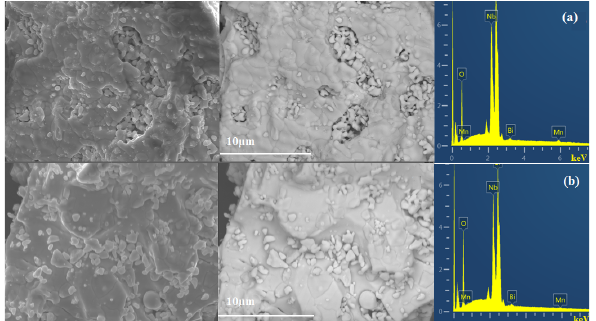
Figure 5: Microscope image of the surface in the mode of sec- ondary and elastically reflected electrons, EDX spectrum of BiNb 0.94 Mn 0.06 O 4− δ (a) and BiNb 0.98 Mn 0.02 O 4− δ (b) with orthorhom- bic and triclinic structures obtained from triclinic modification at 750 6 ∘ C.